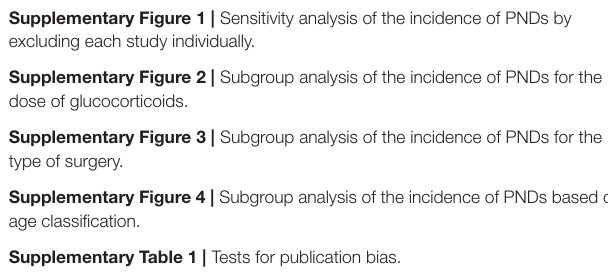
Supplementary Figure 2 | Subgroup analysis of the incidence of PNDs for the dose of glucocorticoids. Supplementary Figure 3 | Subgroup analysis of the incidence of PNDs for the type of surgery. Supplementary Figure 4 | Subgroup analysis of the incidence of PNDs based on age classification. Supplementary Table 1 | Tests for publication bias. Supplementary Table 2 | Meta-regressions for the incidence of